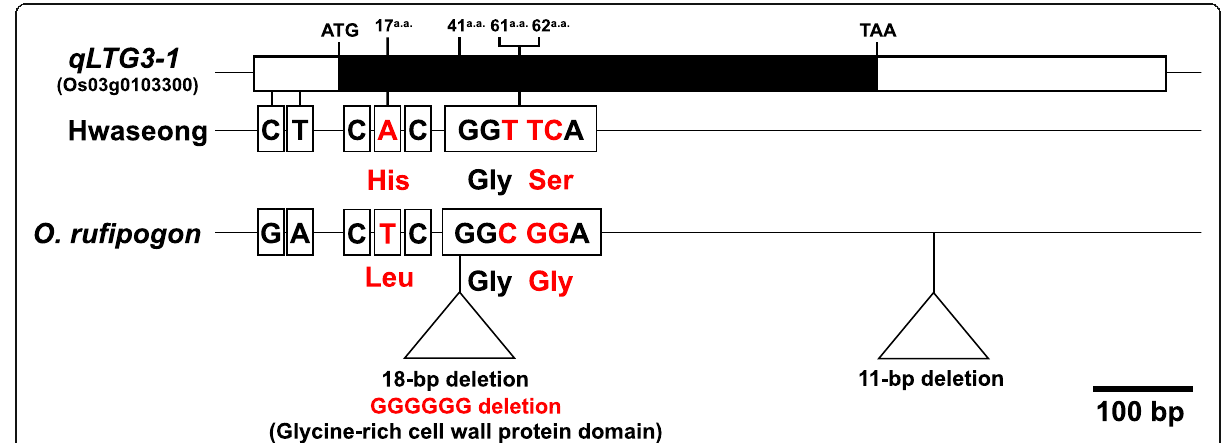
Fig. 3 Sequence comparison of the qLTG3 – 1 gene between the Hwaseong and O. rufipogon. The black box indicates an exon with the position of the amino acid sequence from the start